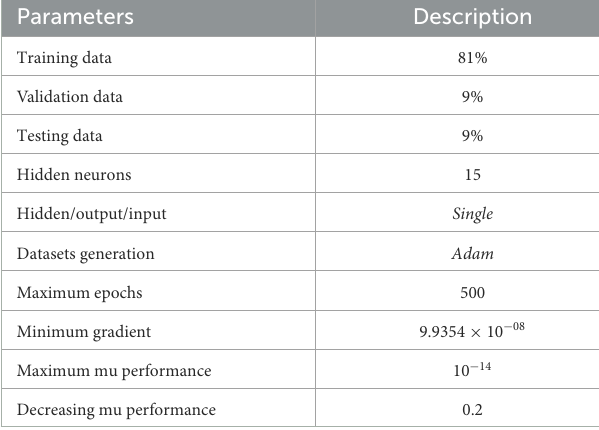
TABLE 2 Values of the parameter utilized for